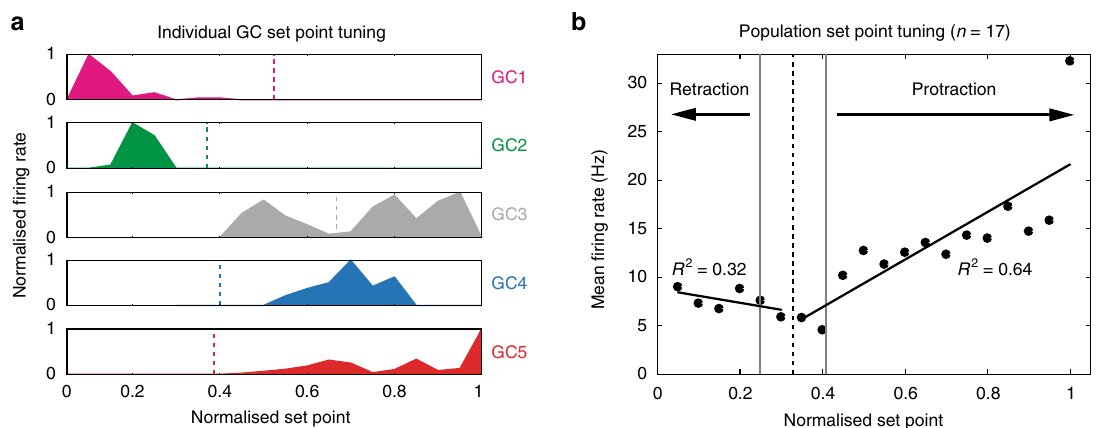
Fig. 5 Set point tuning of cerebellar granule cells. a Five GC examples (GC1 – GC5; WC data) demonstrating signi fi cant tuning of spike output to whisker set point ( P < 0.05, Kolmogorov – Smirnov test). Firing rate was normalised with respect to the maximal rate in each tuning curve. Set point is normalised as percentile for comparison among cells. Individual GCs demonstrated sharp peaks at one or multiple set points. Vertical dashed line s indicate corresponding mean resting positions (when whiskers are not moving) for each GC. b Mean tuning curve for all GCs ( n = 17) exhibiting signi fi cant rate modulation by set point. The data are represented in percentile across population of the whisker data with distinct ranges of set point variable. Black vertical dashed line indicates the mean resting position and grey dotted lines mark S.E.M. Linear regressions were performed over the range of retraction ( R 2 = 0.32) and protraction ( R 2 = 0.64),